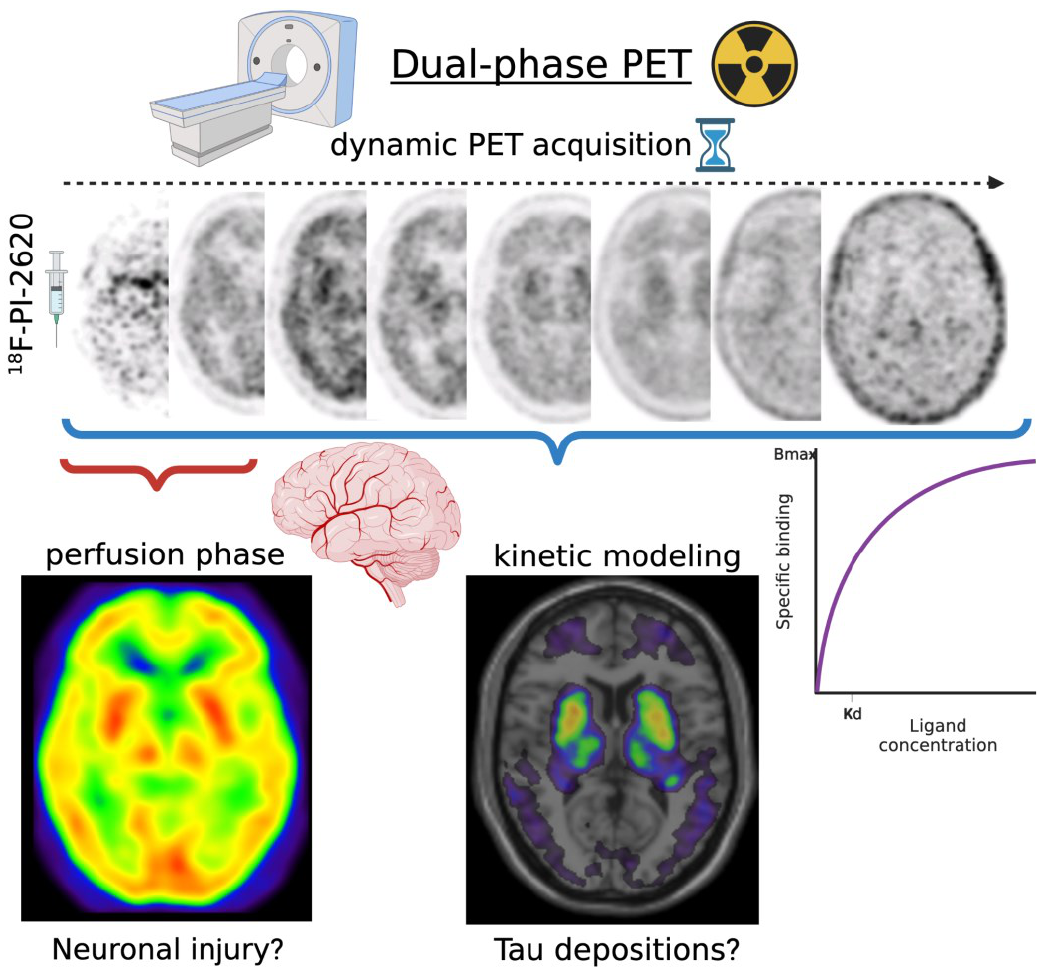
Figure 3. Schematic illustration of dual-phase PET imaging using 18F-PI2620 PET. Created with Biorender.com (accessed on 15 March